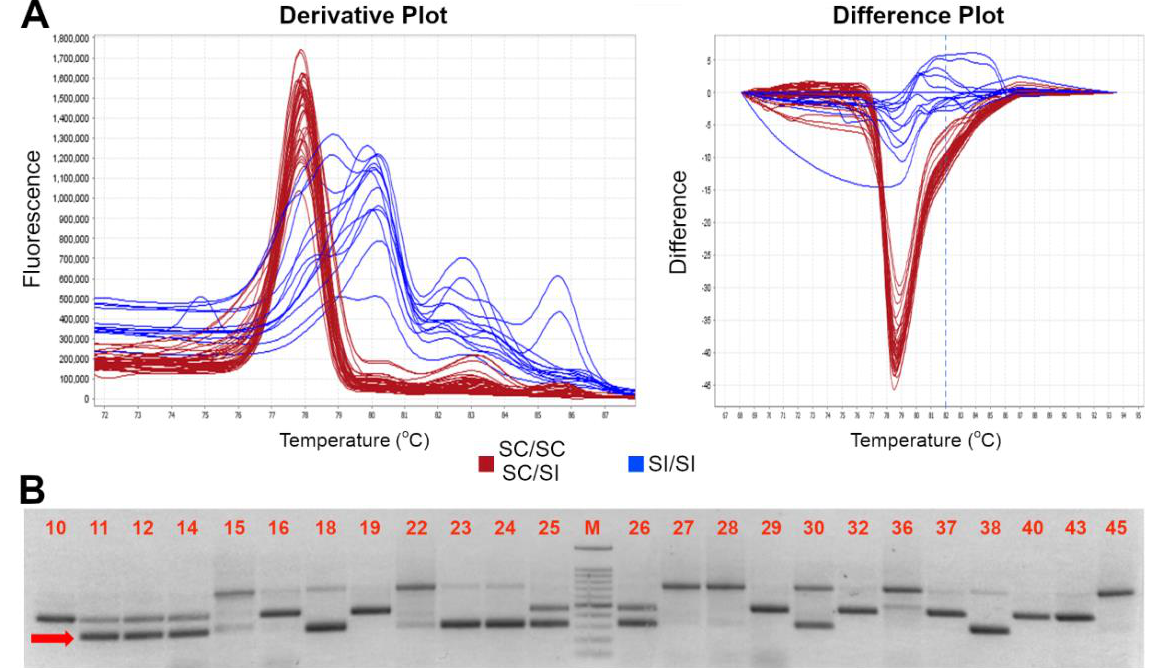
Figure 2. High resolution melting assay for distinction between SC and SI genotypes. ( A ) Derivative (left) and difference (right) plot profiles of the HRMA assay of the S -locus SFB specific amplification by using the SFB INS-F//SFB OUT-R primers; the red and blue color indicated the two different profiles of SC and SI profiles, respectively. ( B ) Electrophoresis gel of HRMA product showing the S C allele (indicated by the red arrow) of ~300 bp long. A 100 bp marker has been used as ladder in the analysis. Accession number is indicated in Table 1.